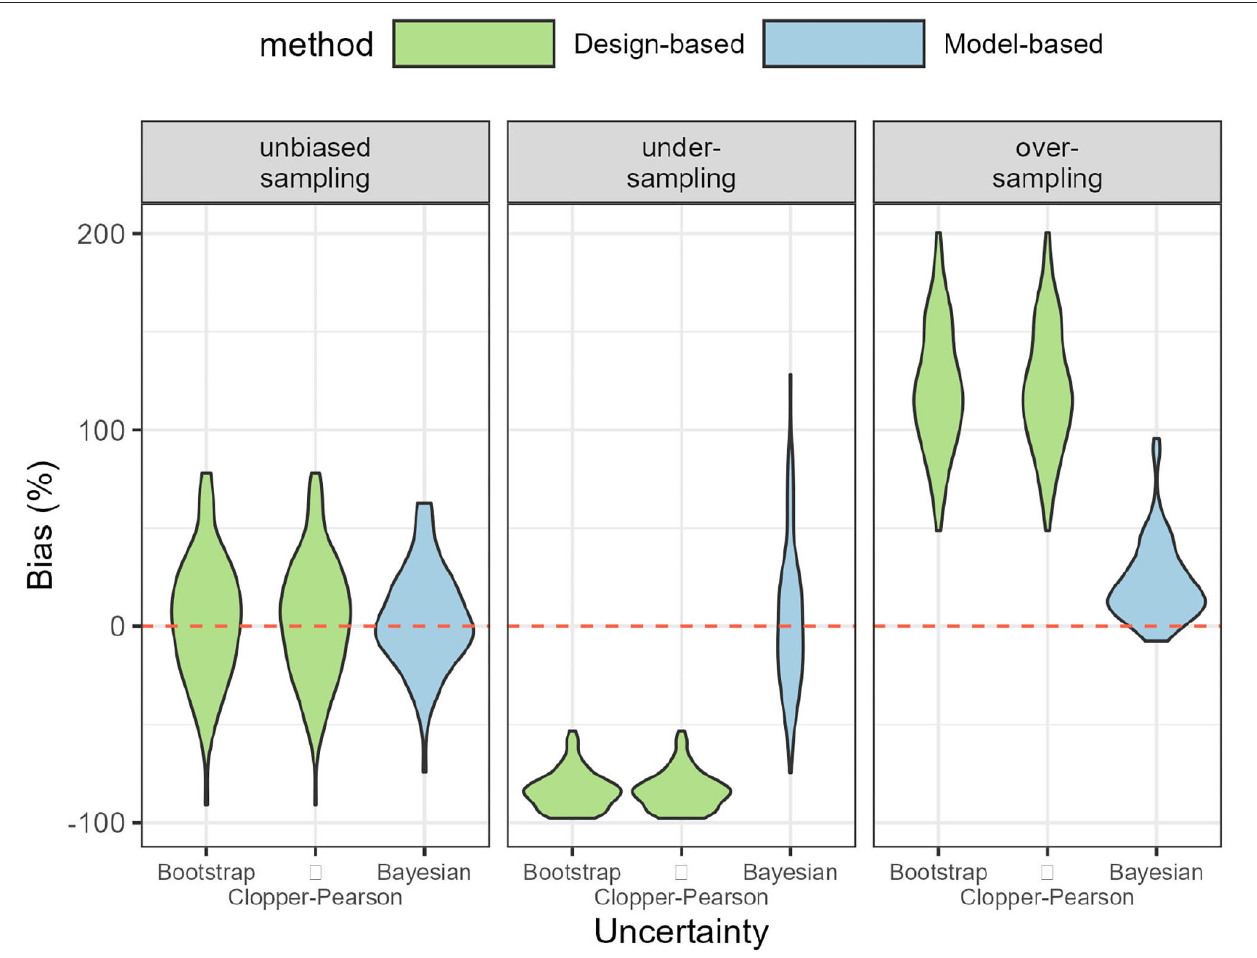
FIGURE 3 | Violin plot of bias in point estimates of total bycatch events. Left: data sampling was unbiased and all methods yielded statistically unbiased estimates. Middle: Under-sampling scenario: only the model-based approach was accurate. Right: Over-sampling scenario: both the design- and model-based approaches were biased upwards. Violin plots are based on 100 simulations.